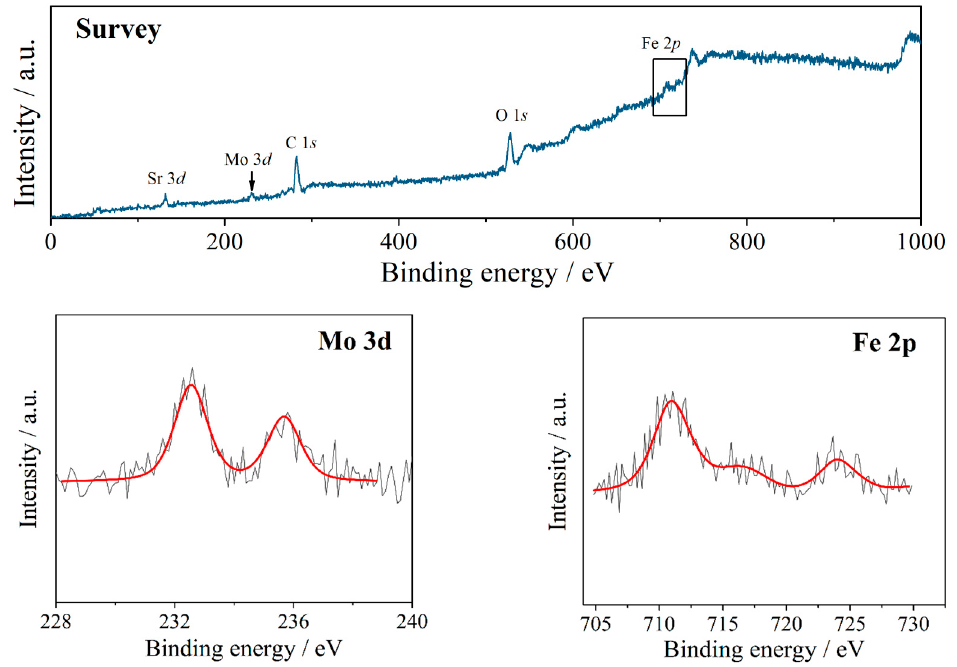
Figure 5. X-ray photoelectron spectra for Sr 2 Fe 1.5 Mo 0.5 O 6 −δ .